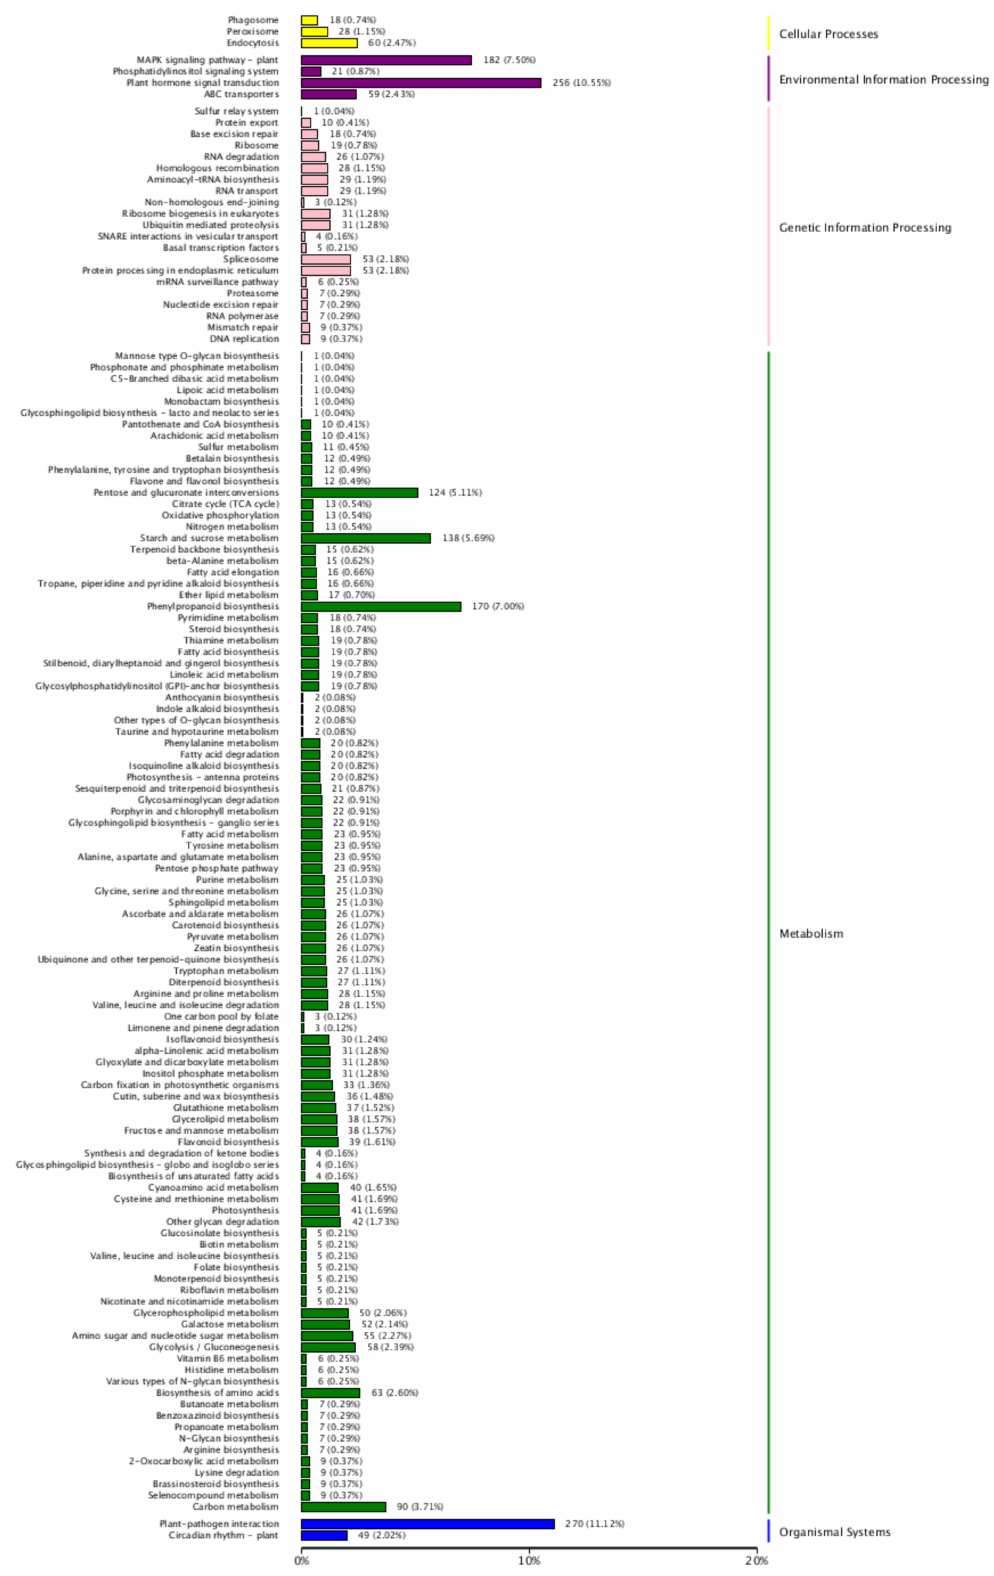
Figure 4. Kyoto Encyclopedia of Genes and Genomes (KEGG) classifications of differentially ex- pressed genes of the samples inodulated with different